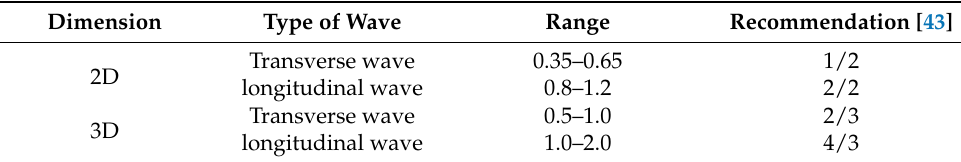
Table 1. Range of adjustment coefficients for the viscous boundary. Dimension Type of Wave Range Recommendation [43] Transverse wave 2D